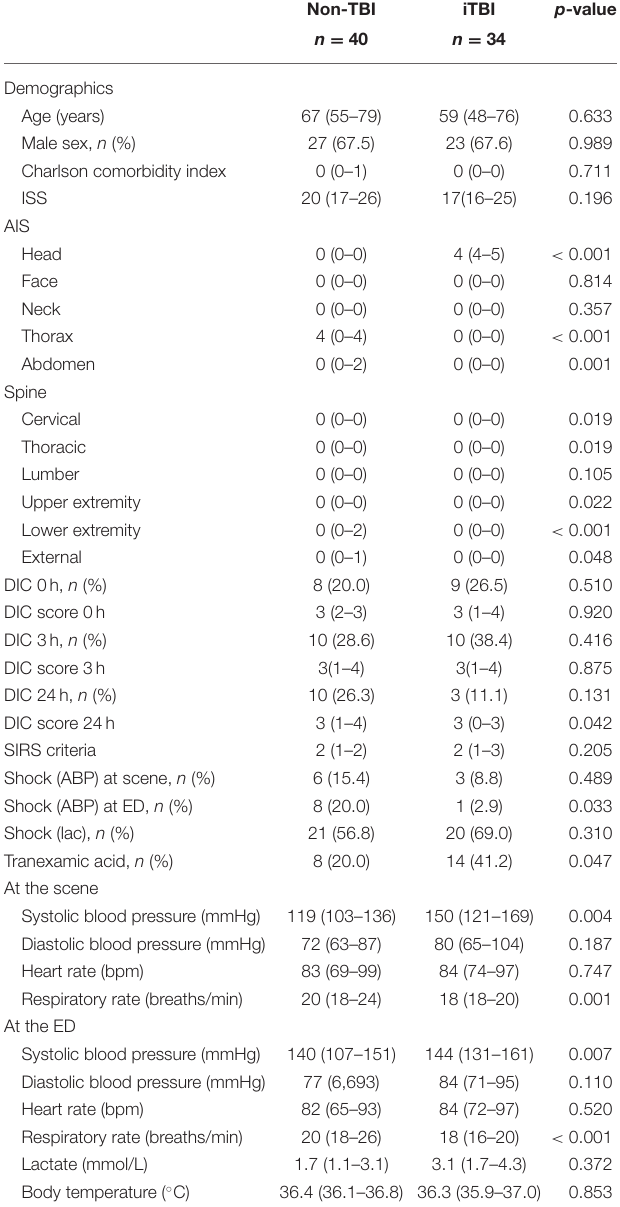
TABLE 2 | Requirement for transfusion and emergency surgery, and in-hospital TABLE 1 | Demographics and parameters at the scene and admission to the mortality. emergency department in patients with isolated traumatic brain injury and non-traumatic brain injury. Non-TBI iTBI p -value